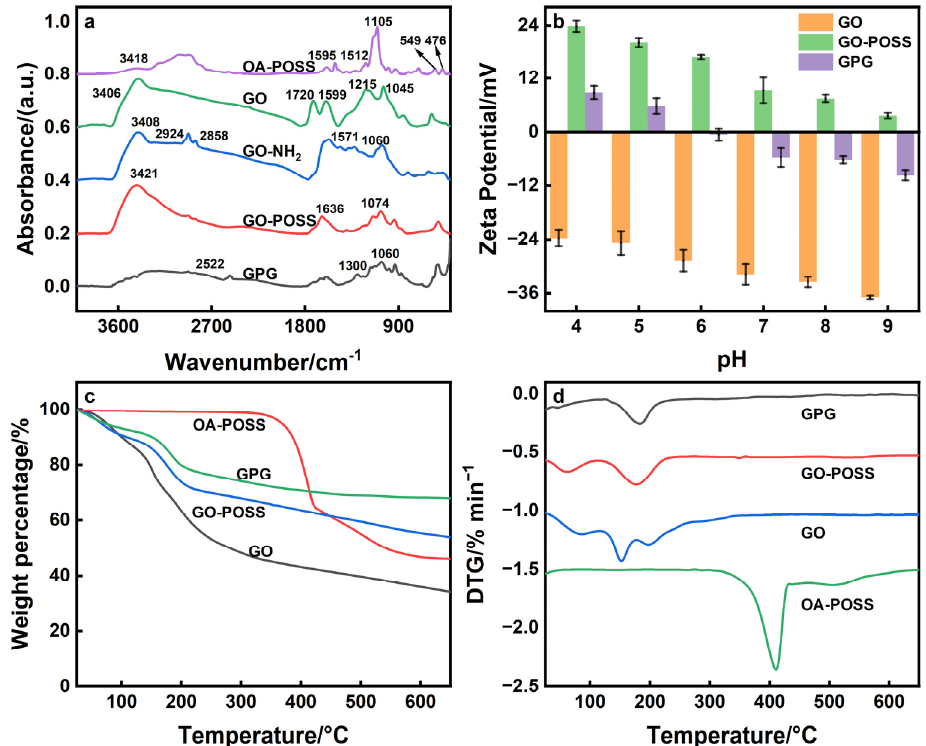
Figure 3. ( a ) FTIR spectra of OA–POSS, GO, GO-NH 2 , GO–POSS, and GPG composite. ( b ) Zeta potentials of GO, GO–POSS, and GPG composite. ( c ) TGA curves of GO, OA–POSS, GO–POSS, and GPG composite. ( d ) DTG curves of GO, OA–POSS, GO–POSS, and GPG composite.